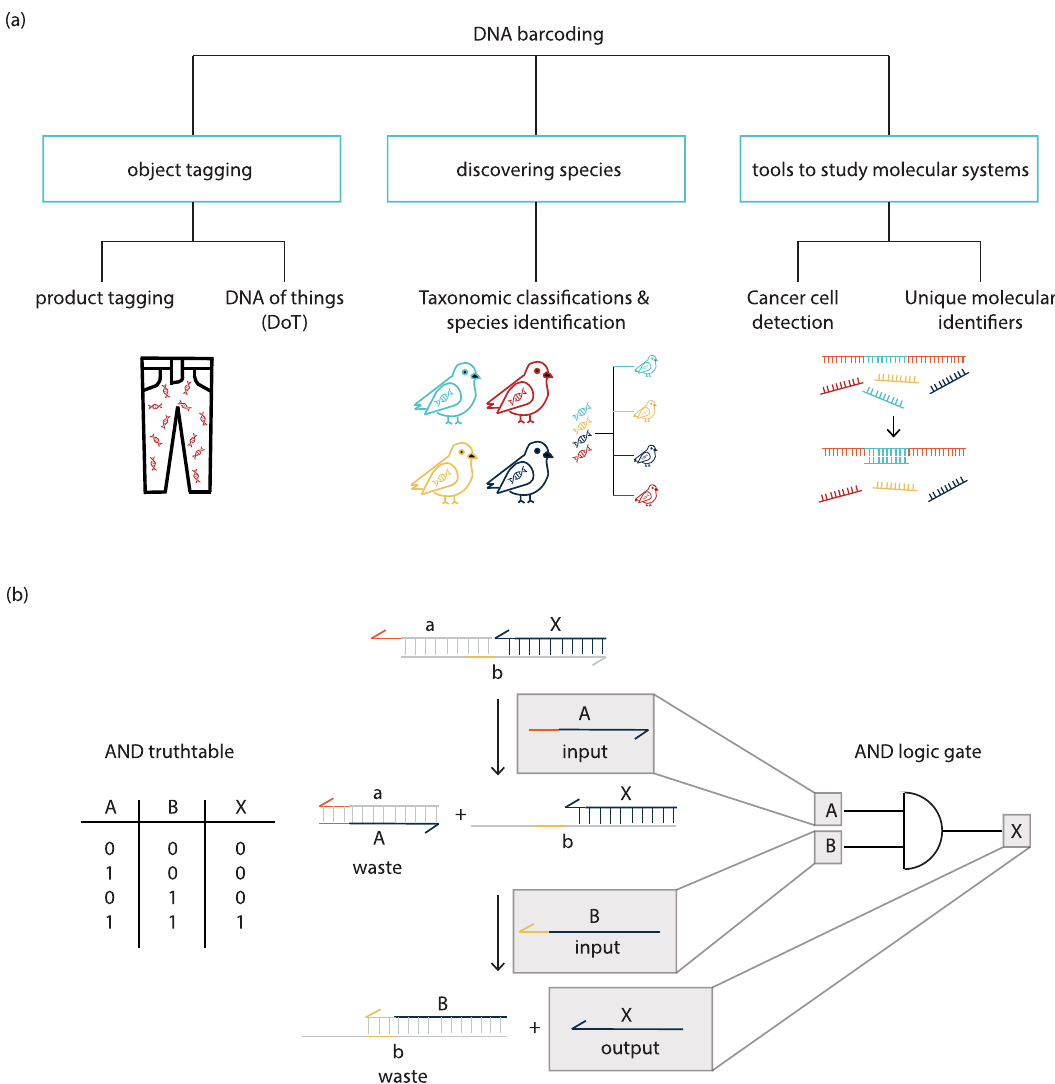
Fig. 4 DNA for identi fi cation and computing applications. a Applications of DNA barcoding. Applications include product tagging and DNA of things, as discussed in this review, but also species identi fi cation, cancer cell detection, or unique molecular identi fi ers, which lie outside of the scope of this review. b AND logic gate and truth table. DNA logic gates with input signal strands «A» and «B» and output signal strand «X». Toehold regions are marked in orange and yellow, signal strands are marked with capital letters and complementary strands are marked with lower case letters. Signal strands are dark blue whereas all other strands are gray. Input signal A binds to gate complex (containing strands a, b, and X) and displaces a part of strand b to form “ waste ” complex A-a. Input signal B is then added. It displaces output signal X from the complex to bind with b, forming “ waste ” complex B-b. Single strand X is the output signal of the